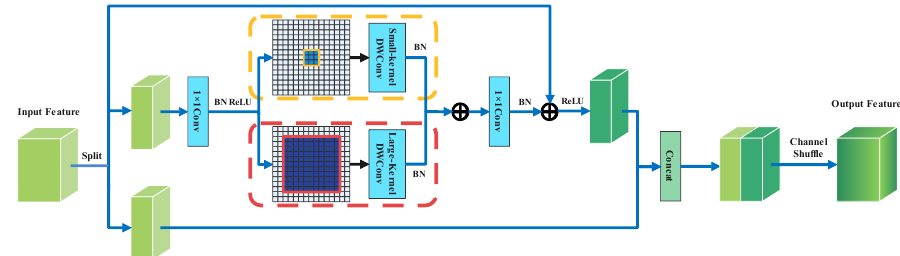
Figure 2. Details of the local contextual block. DWConv stands for DepthWise